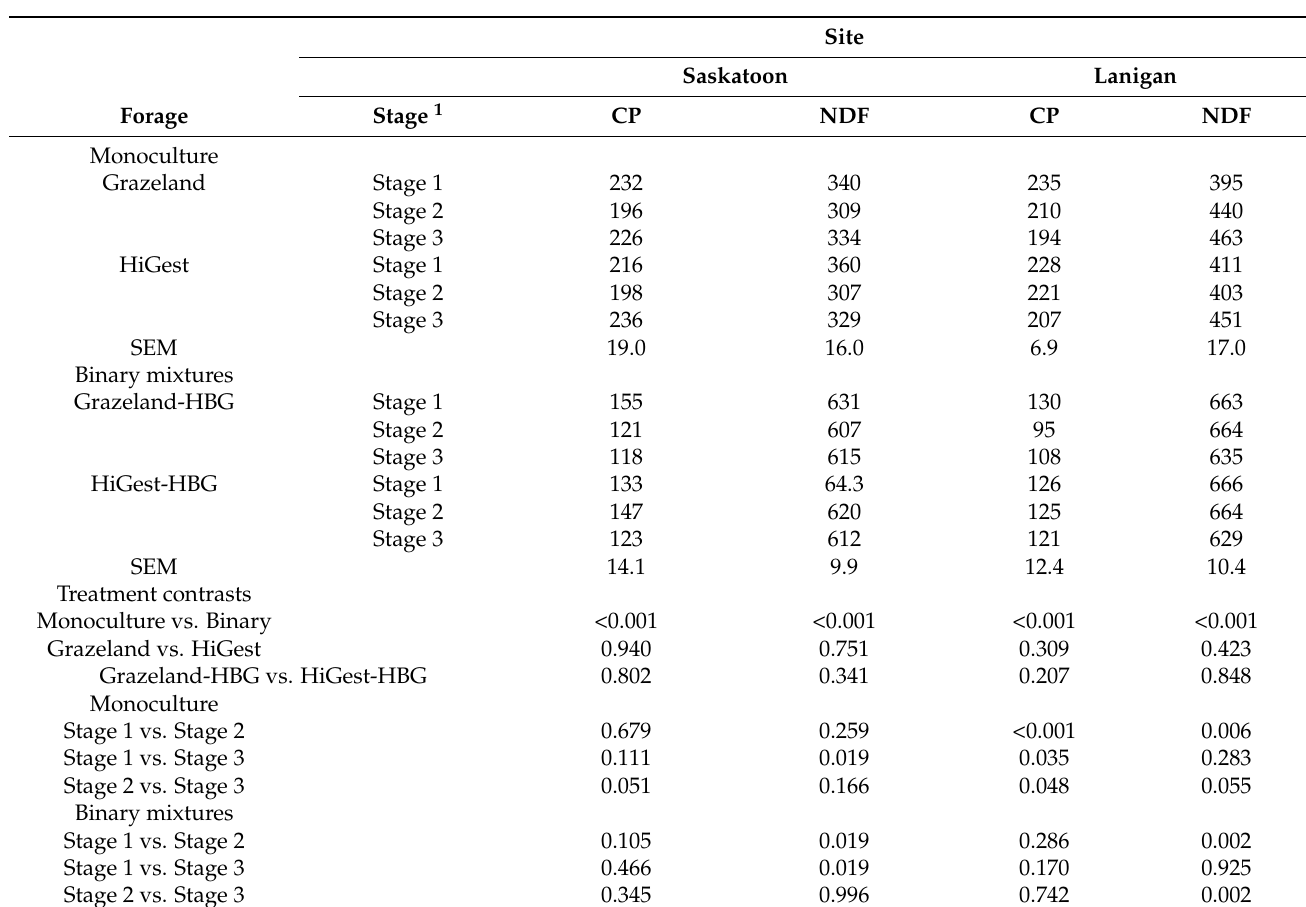
Table 1. The CP and NDF (g kg − 1 DM) of low-lignin alfalfa cultivar ‘Hi-Gest ® 360’ in monocul- ture and in binary mixtures with AC Success hybrid bromegrass (HBG) in Saskatoon and Lani- gan,